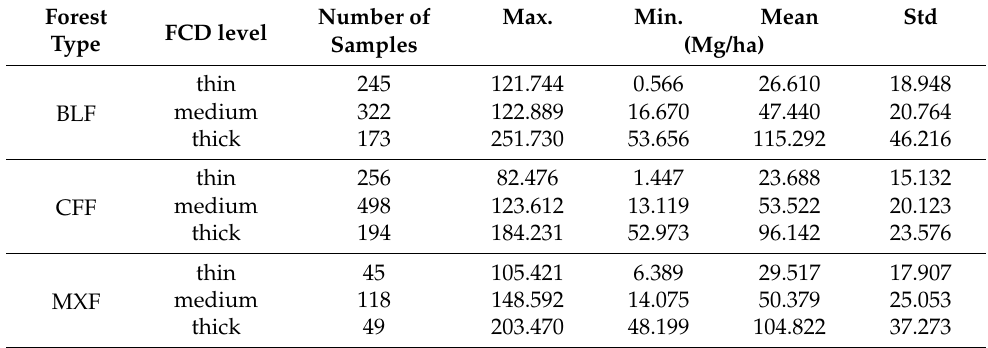
Table 5. The biomass statistics of the FCD samples in 2015.